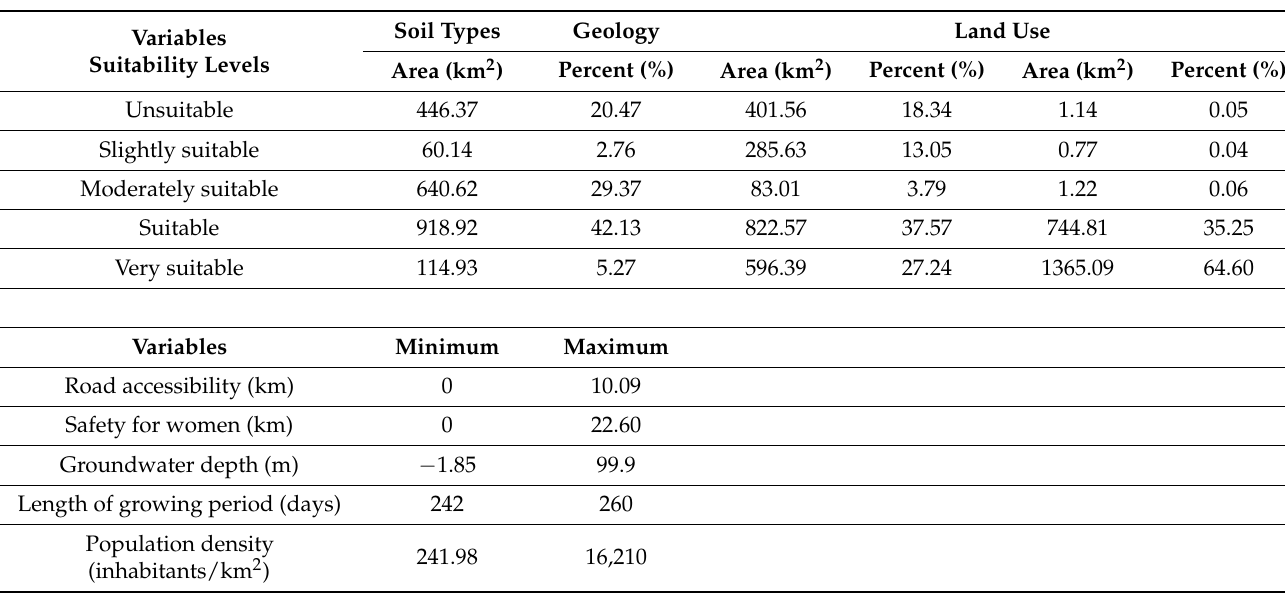
Table 4. Description of independent